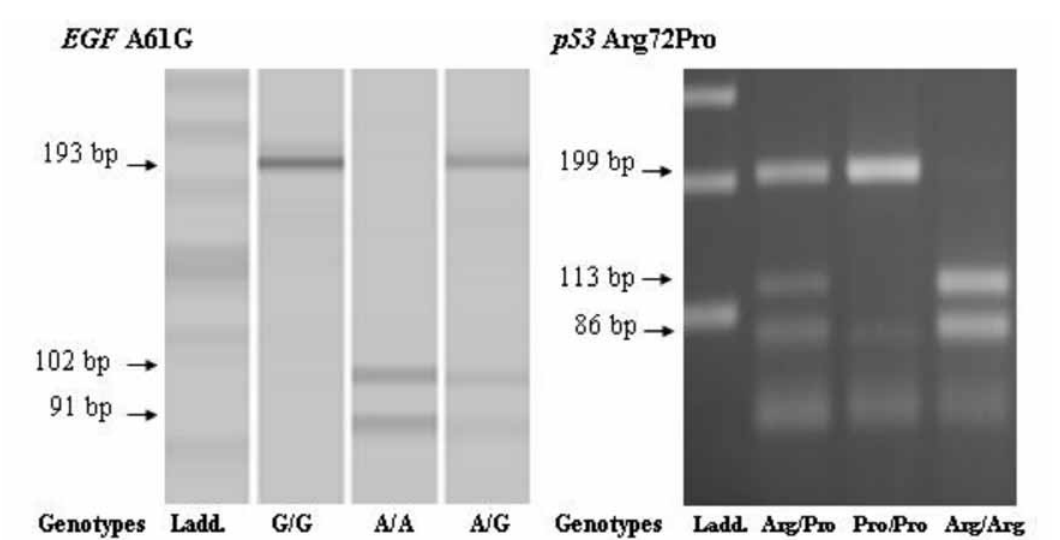
Figure 1. Product of PCR-RFLP analysis of EGF A61G (left) and p53 Arg72Pro (right) polymorphisms digested with AluI (MultiNa multichip electrophoresis) and Bst UI (agarose